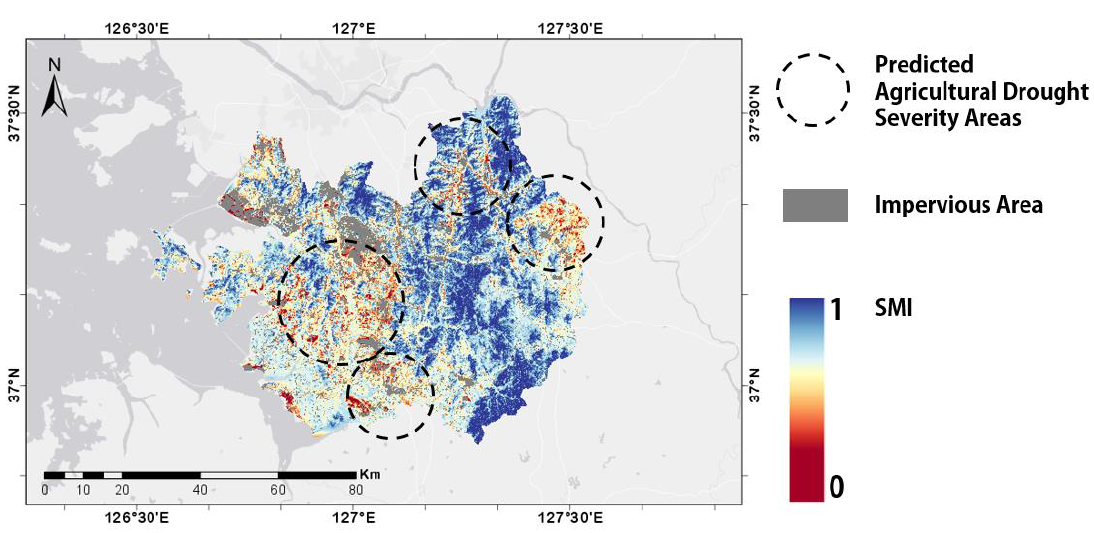
Figure 5. Predicted agricultural drought map (excluding for the impervious areas) after non-rainfall during the three-month period from 22 March 2018 to 26 June 2018.